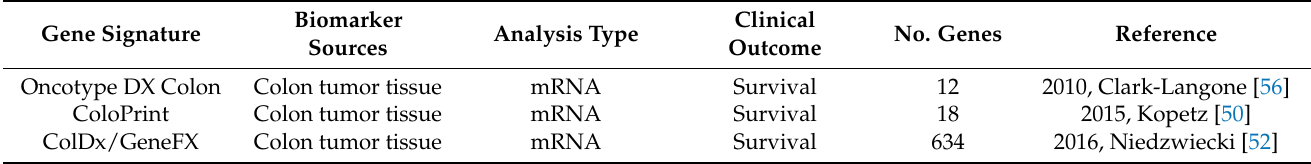
Table 1. Commercial gene expression signatures for colorectal